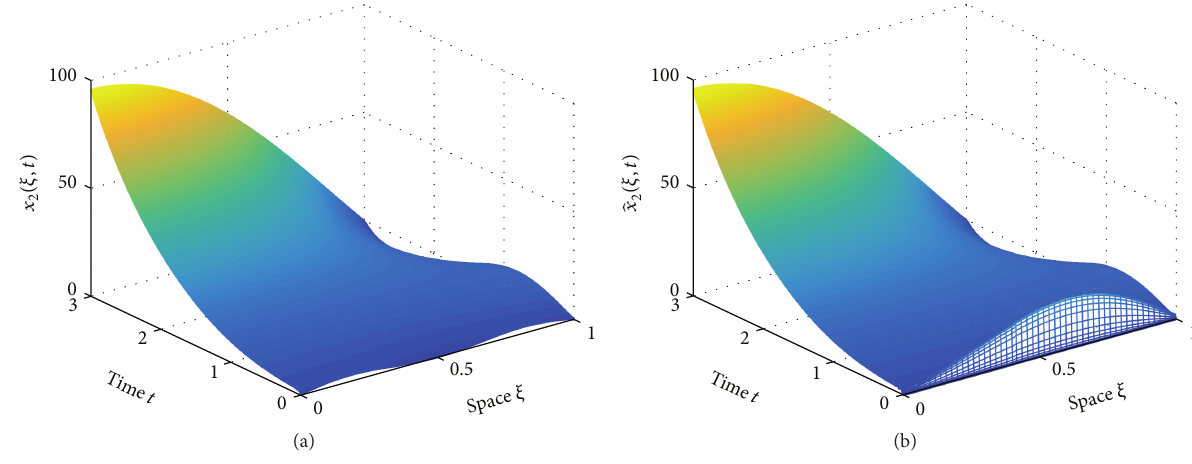
Figure 4: Spatiotemporal evolution of 𝑥 2 (𝜉, 𝑡) (a) and ̂𝑥 2 (𝜉,𝑡) (b).